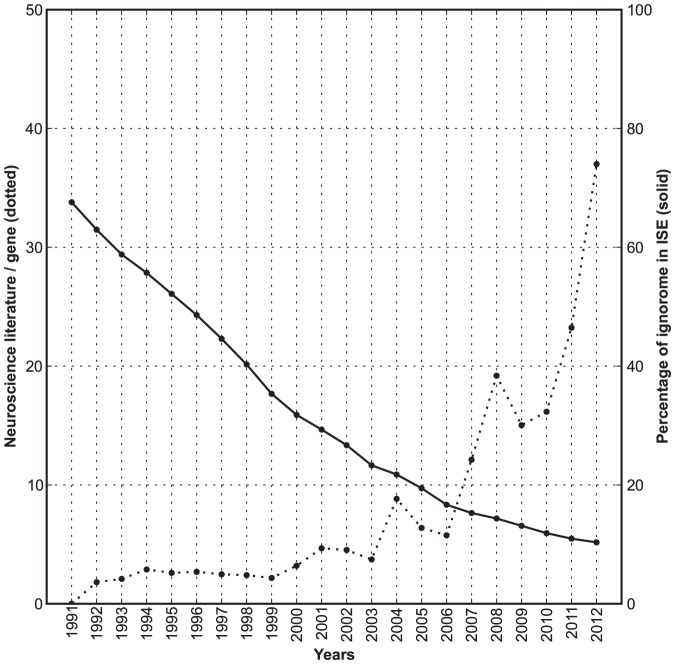
Shrinkage of the ignorome.The x-axis represents the timeline. The solid line represents the percentage of ignorome genes in the ISE brain set. The dotted line represents the number of neuroscience specific literature (in thousands).